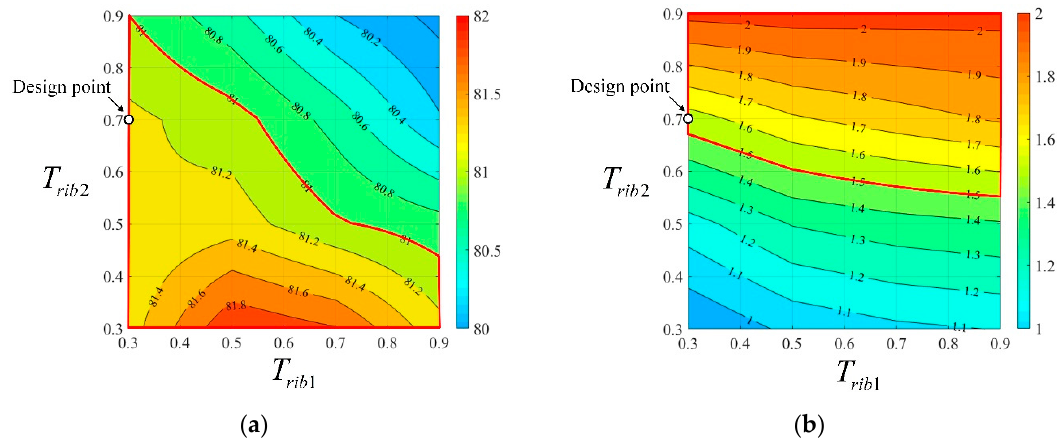
Figure 12. FEA result according to the design parameter of rib ( a ) safety factor, and ( b ) power factor.